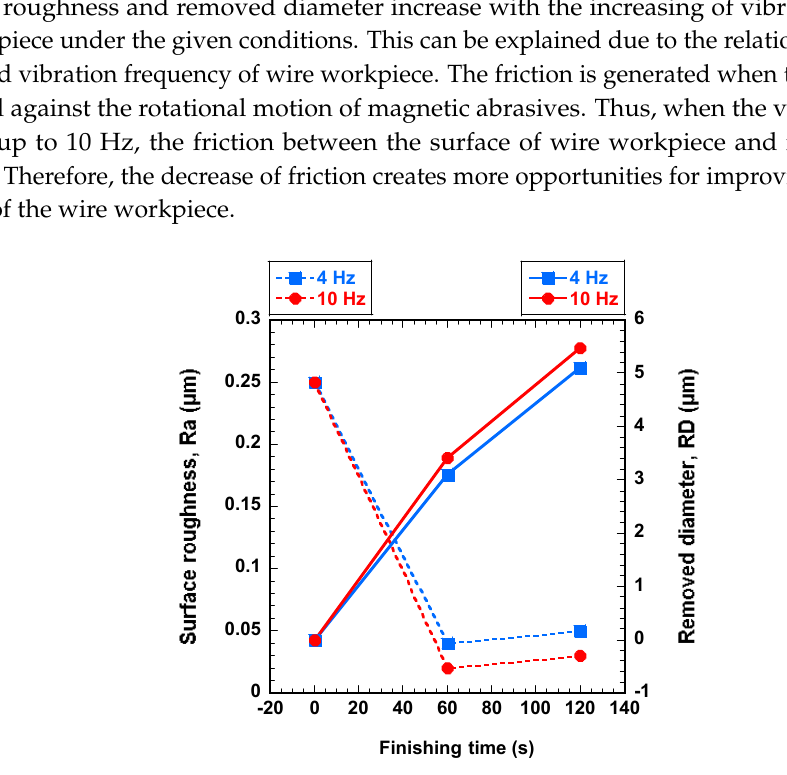
Figure 7. Effect of vibration frequency of wire workpiece on surface roughness and the removed diameter (abrasive: 0.5 µm, rotational speed: 800rpm).